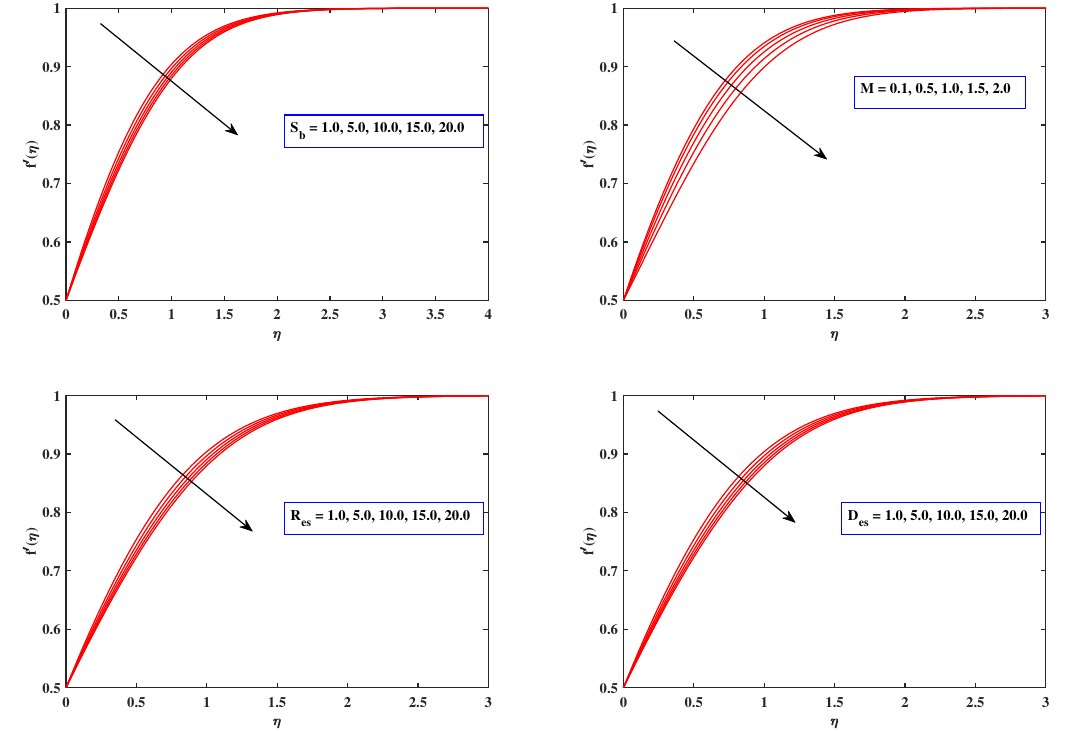
Figure 4. Fluctuation in velocity profile with S b , M , R es and D es .